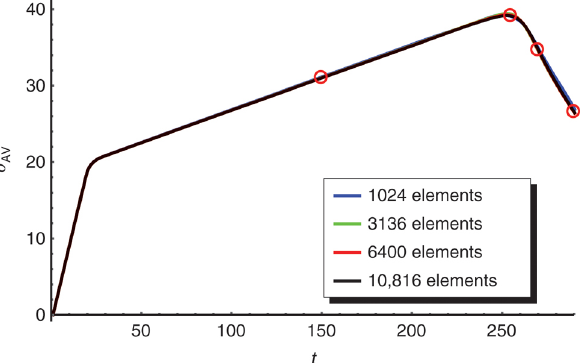
Figure 7: Shear: global stress response for 1024, 3136, 6400 and 10,816 elements (blue, green, red and black), highlighted in red at steps 150, 255, 270 and 290 (from left to